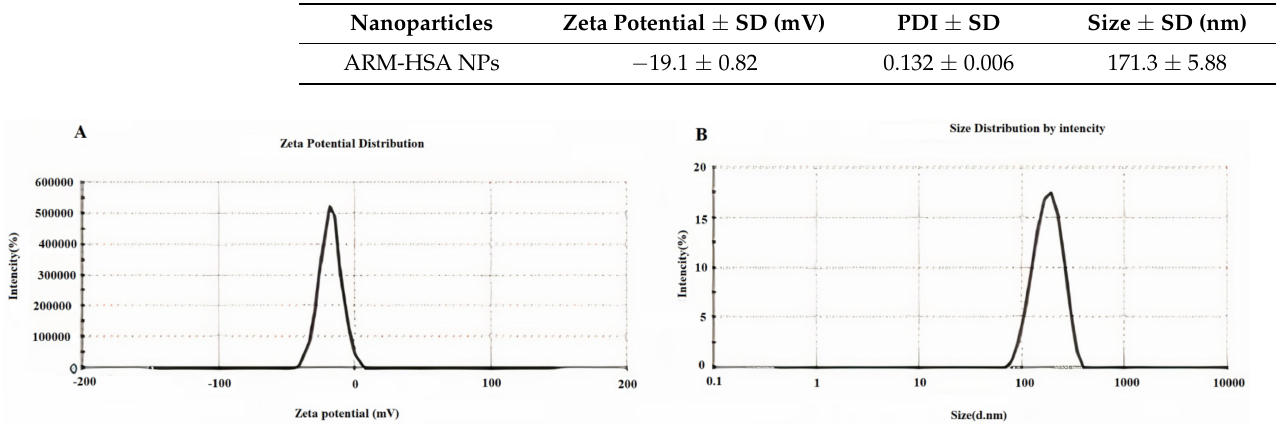
Table 1. Zeta potential, PDI and size of Albumin–artemether nanoparticles (mean ± SD).